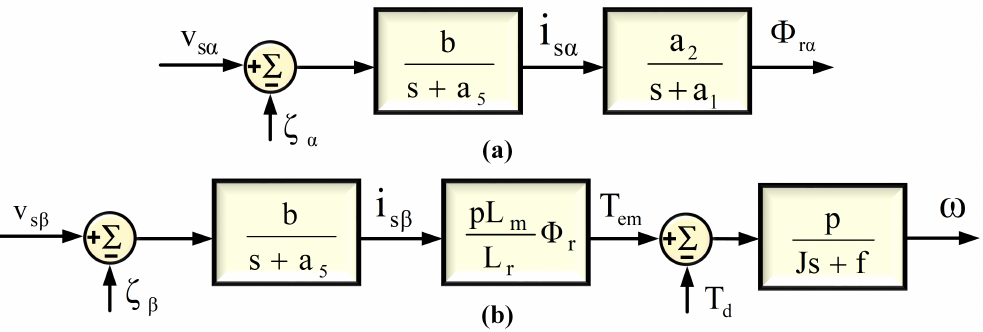
Figure 3. The two block diagrams of the induction motor according to ( a ) α and ( b ) β